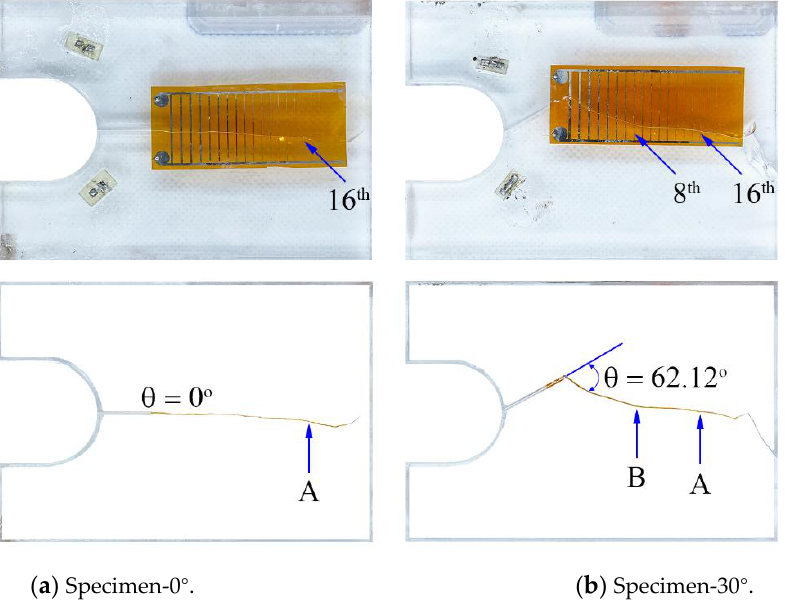
Figure 6. Crack fracture patterns of the specimens. ( a ) The crack pattern of the specimen-0 ° . ( b ) The Figure6. Crackfracturepatternsofthespecimens. ( a )Thecrackpatternofthespecimen-0 ◦ . ( b )Thecrack crack pattern of the specimen-30 ° . pattern of the specimen-30 ◦